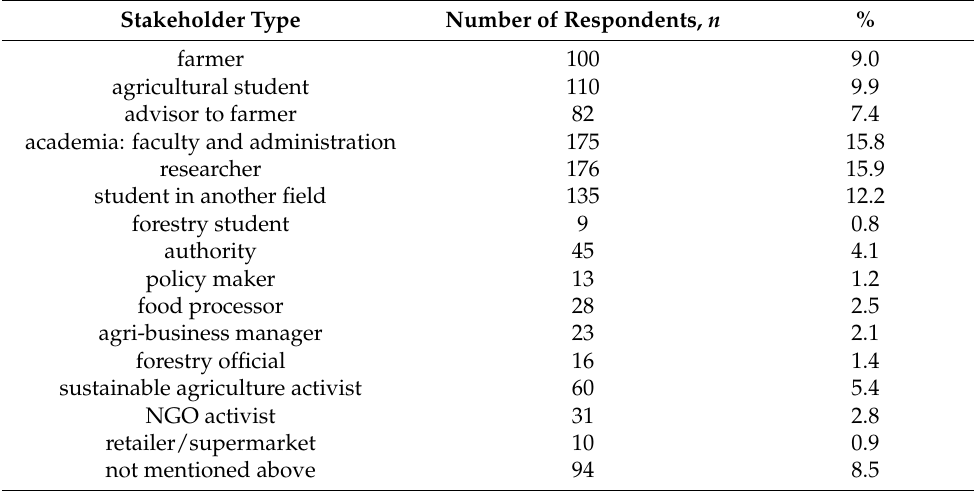
Table 1. Distribution of the stakeholders’ types mentioned by the respondents ( n =